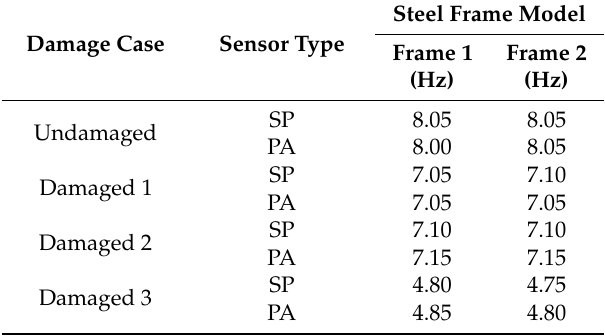
Table 4. First modal frequency results obtained using the PAs and